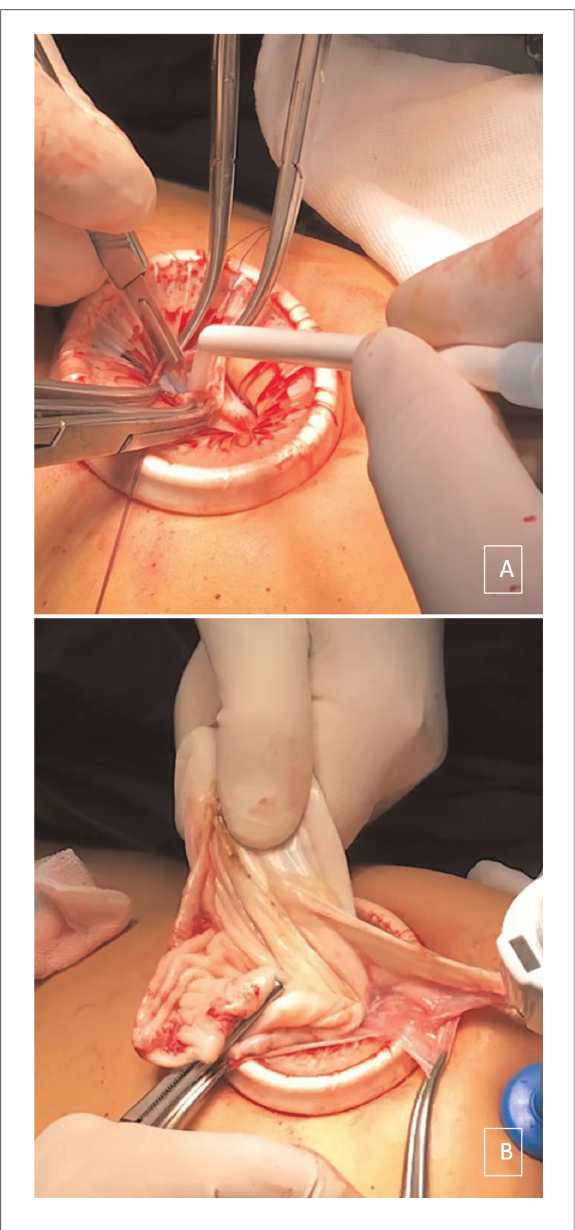
FIGURE 3 Alexis XS retractor inserted at the level of the umbilical access in order to carefully puncture the cyst using a suction irrigation apparatus ( A ), and extracorporeal cyst excision ( B